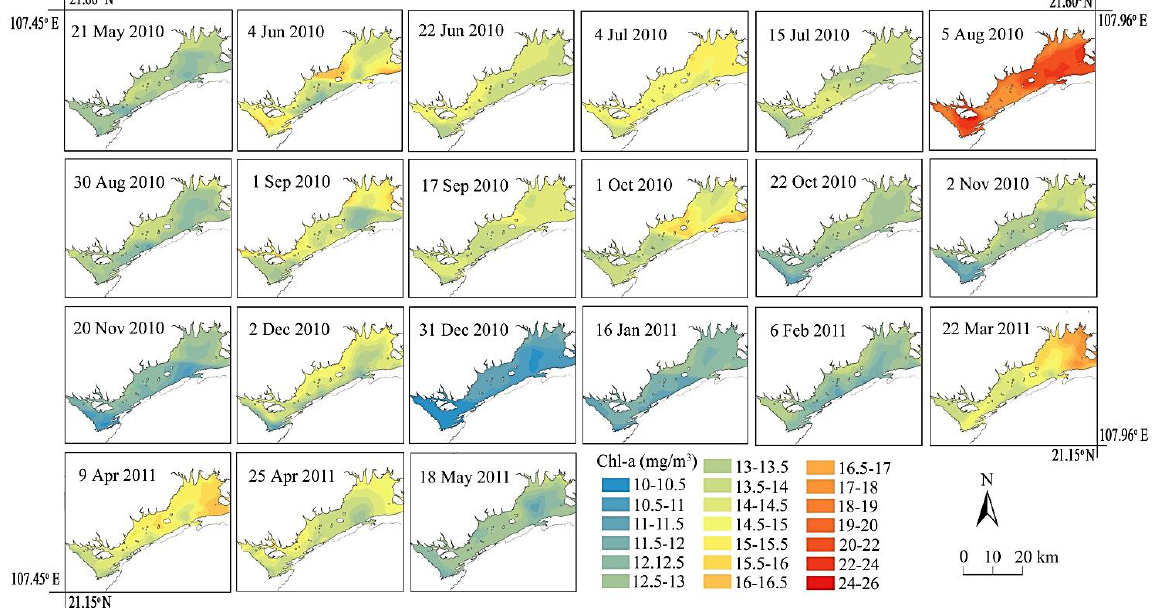
Figure 8. Spatio-temporal changes of Chl-a concentrations for the year from May 2010, to May 2011, over Tien Yen Bay produced from 21 MODIS scene data, rGBr and